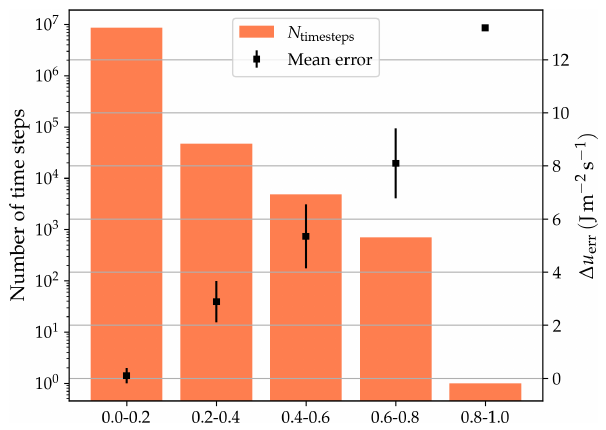
Figure 5. The histogram shows the energy conservation error, as a percentage of the energy input, incurred at every time step. The symbols indicate the mean absolute error corresponding to each bin. The error bars indicate ± 1 σ around the mean. The plots are derived from data from the historical period of all LSM simulations in this study.